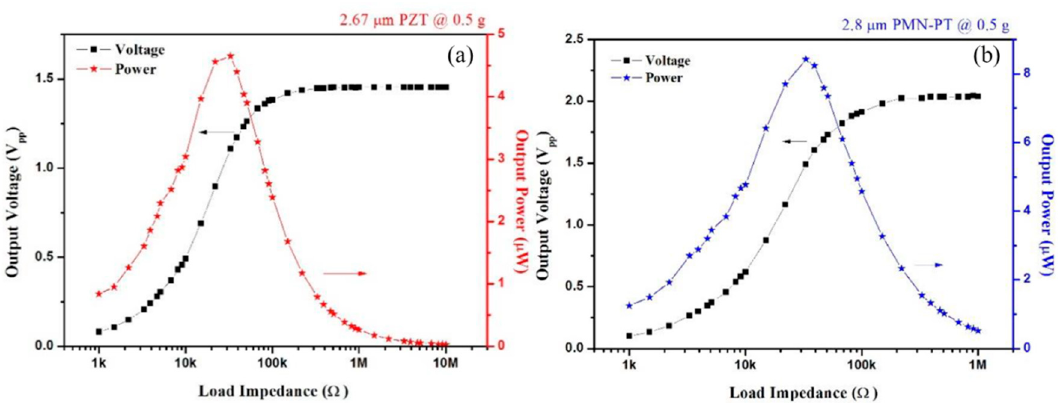
Figure 26. Output performance of piezoelectric energy harvesters (EHs) based on ( a ) PZT and ( b ) lead magnesium niobate-lead titanate (PMN-PT), under a 0.5 g acceleration [64]. © Copyright 2016, Artic. J. Phys. Conf.